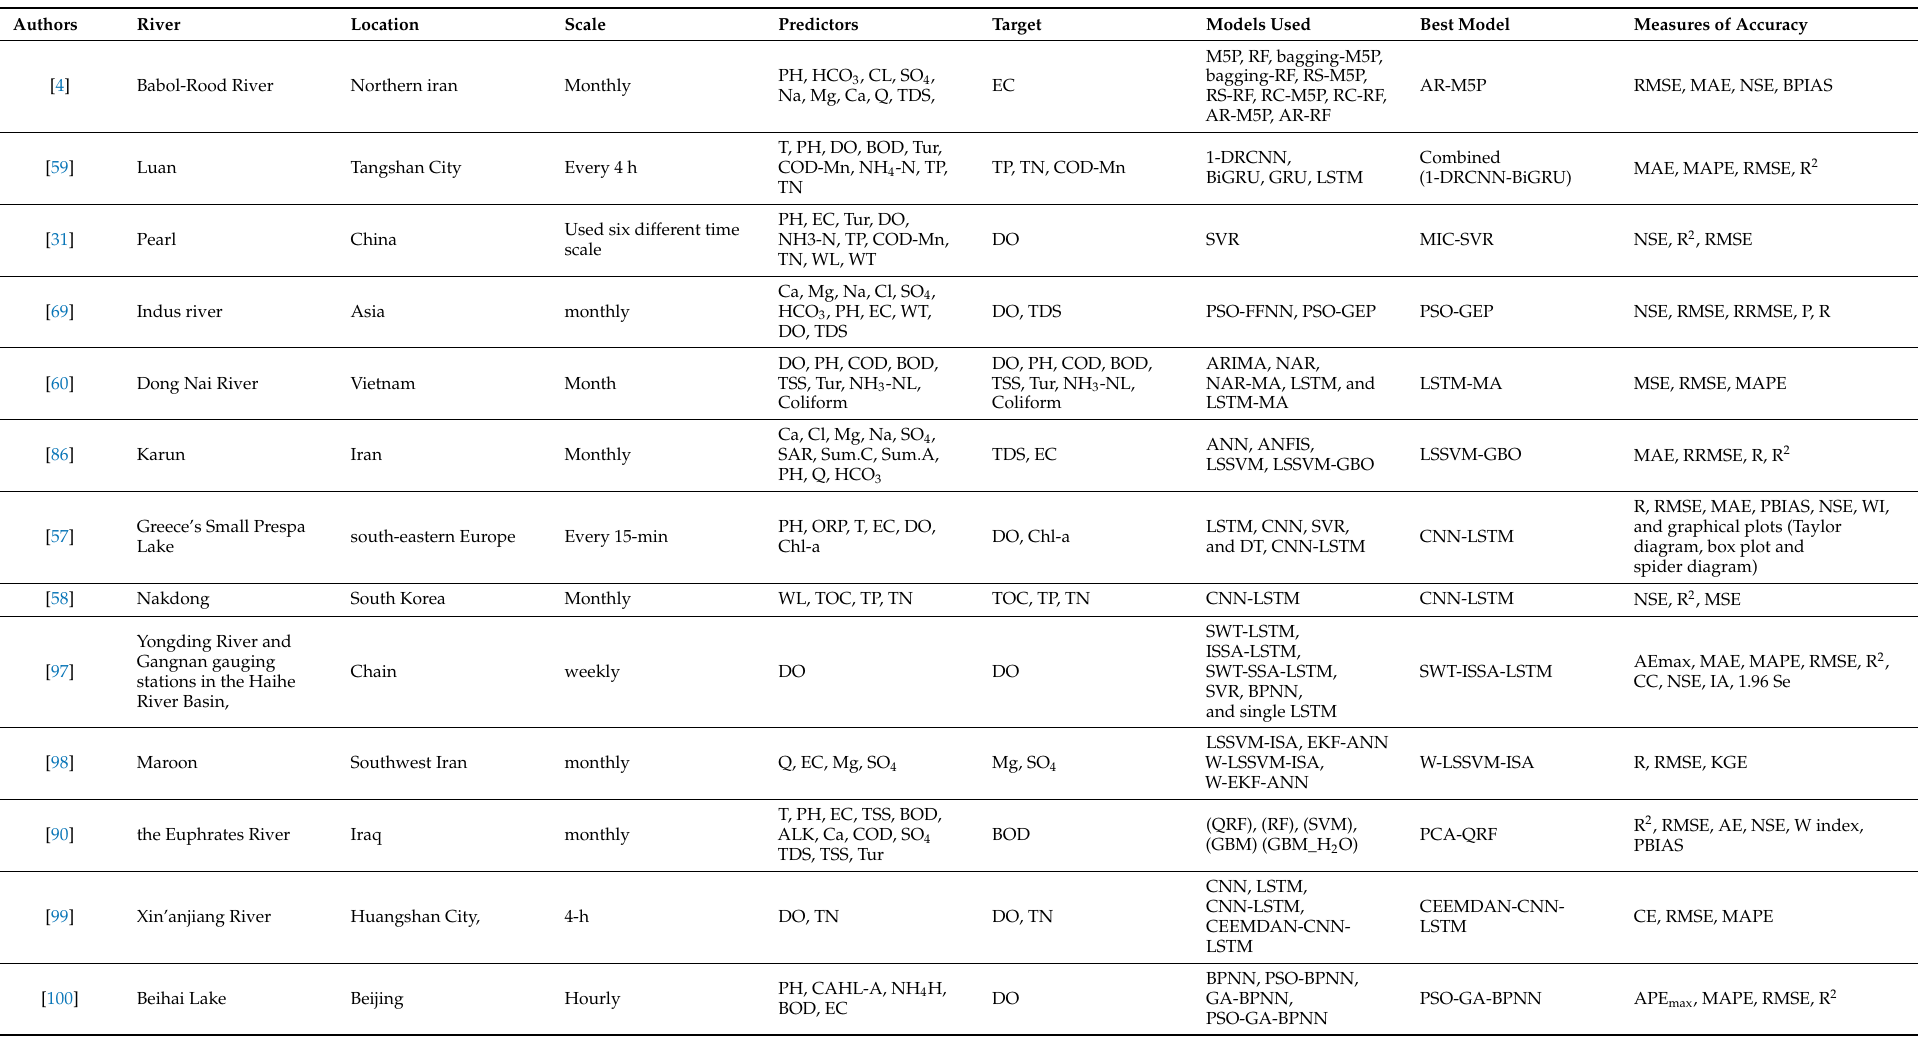
Table 3. Summary of application of different type hybrid models in WQ